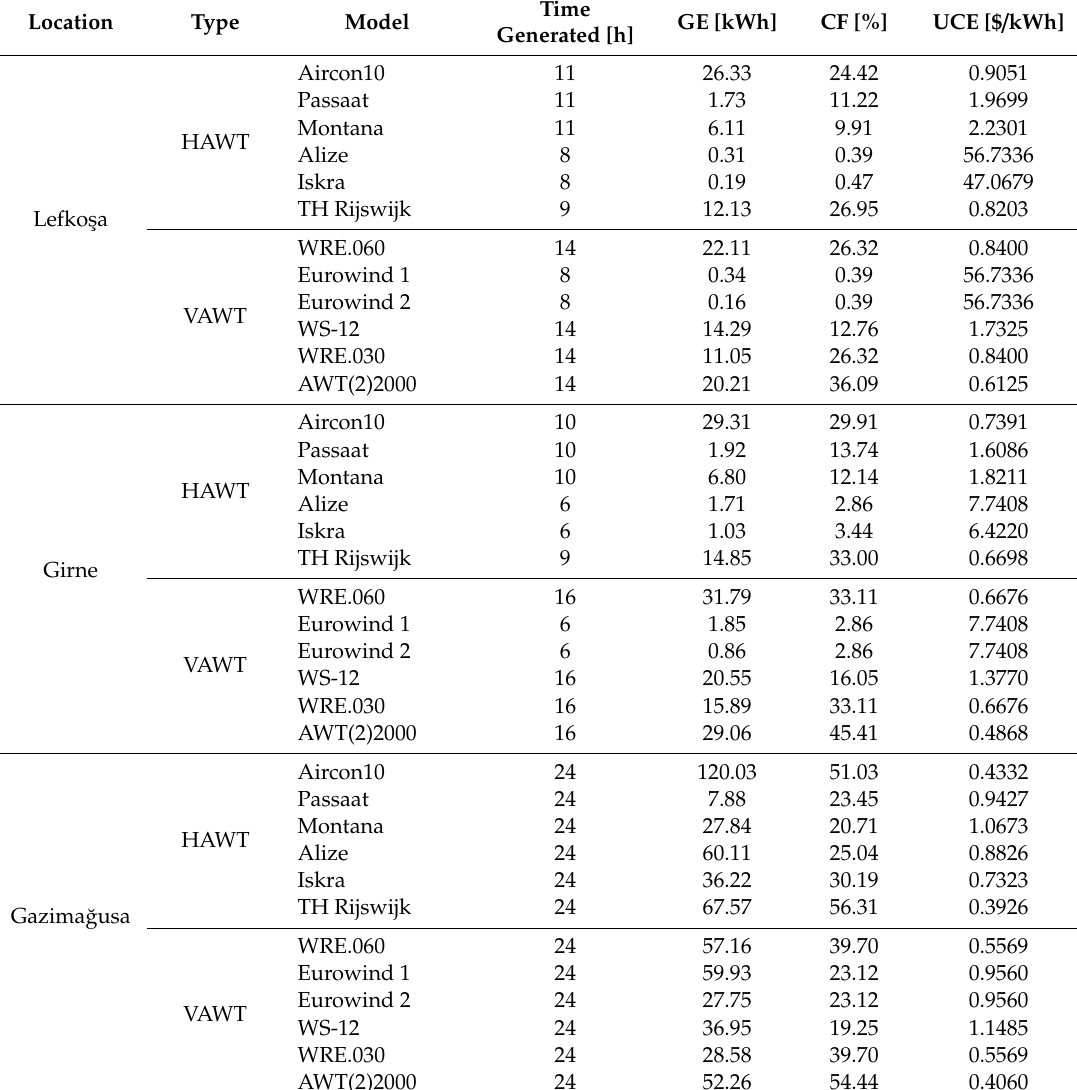
Table 8. Capacity factor and Generated electricity of wind turbine system at 18 m hub-height.